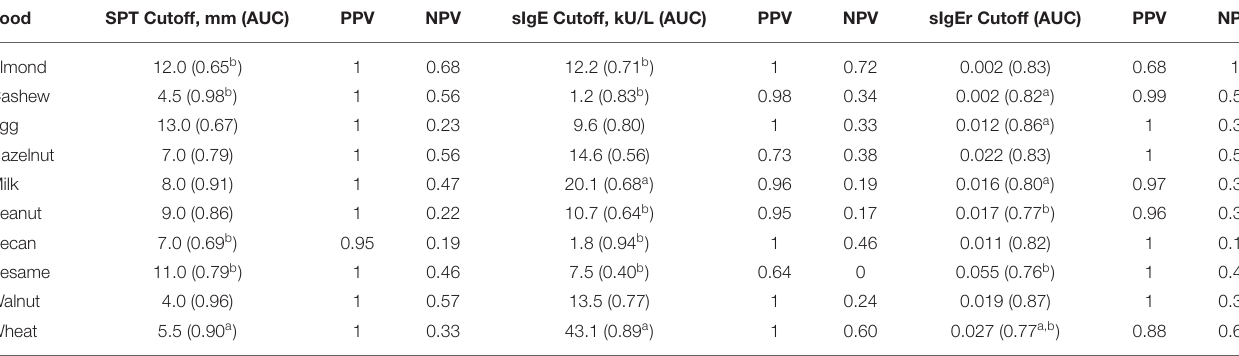
TABLE 6 | CTD-dependent ROC thresholds at 500mg CTD.